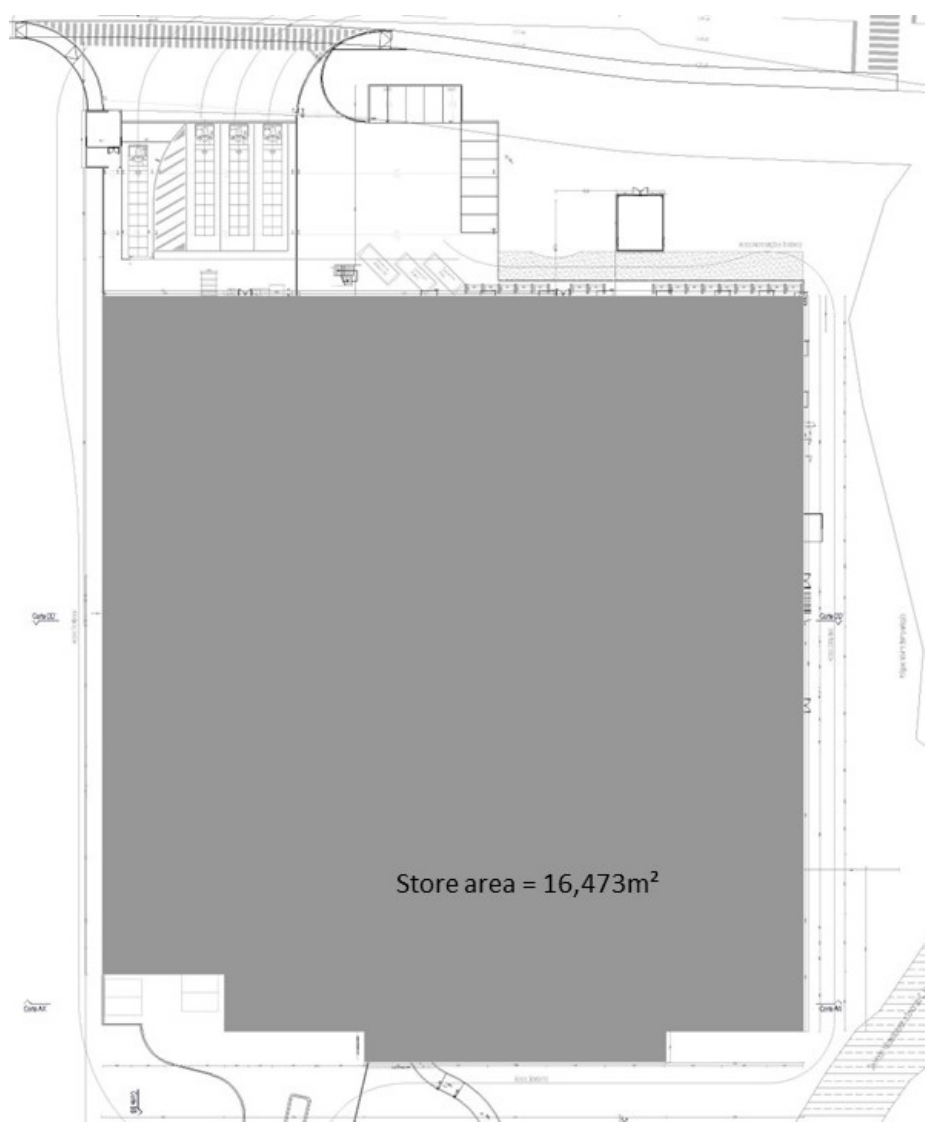
(Figure 3). The main facade of the building is opaque, and the window-to-wall ratio is about 5%, with southeast exposure (Figure 4).